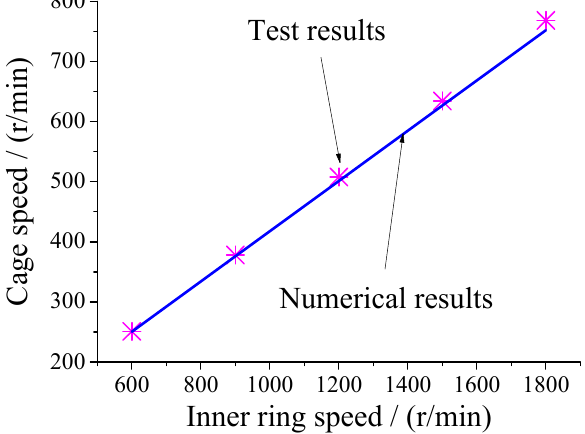
Figure 18. Comparison between the tested and numerical values of cage speed under different inner ring speeds (radial load: 400 N, kinematic viscosity: 15 cSt).